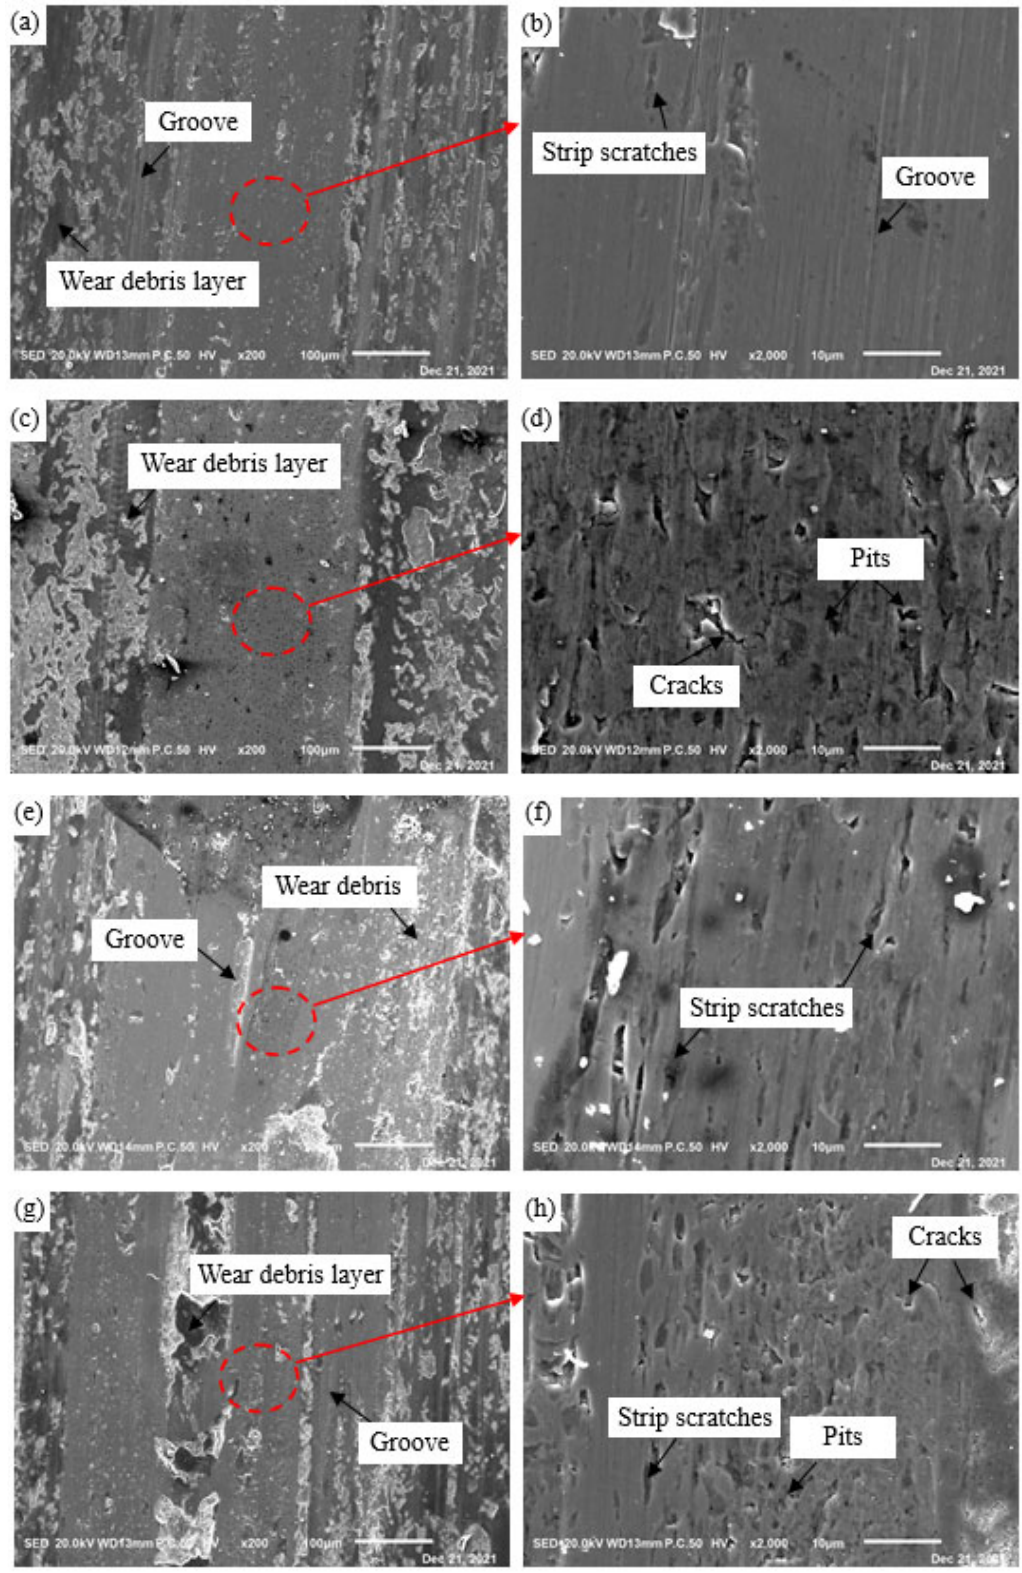
Figure 12. Worn morphologies of steels austempered at different temperatures for 8 h: ( a , b ) GCr15SiMo at 210 °C; ( c , d ) GCr15Si1Mo at 210 °C; ( e , f ) GCr15SiMo at 230 °C; ( g , h ) GCr15Si1Mo at 230 °C.